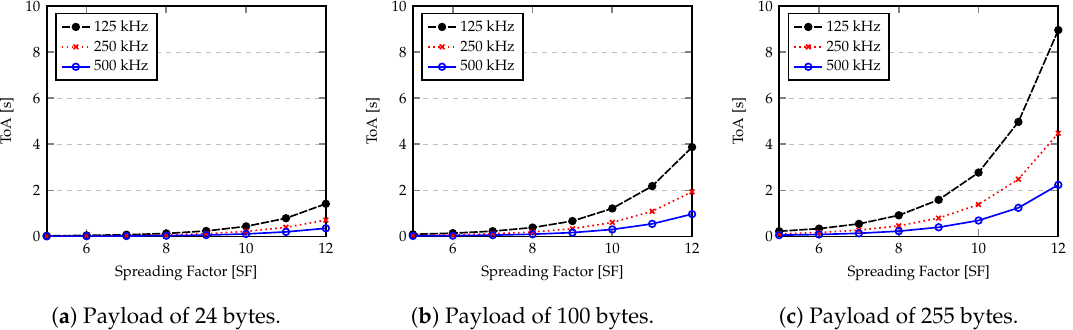
Figure 11. Packet Time on Air (ToA) for different payload length according to Bandwidth and Spreading